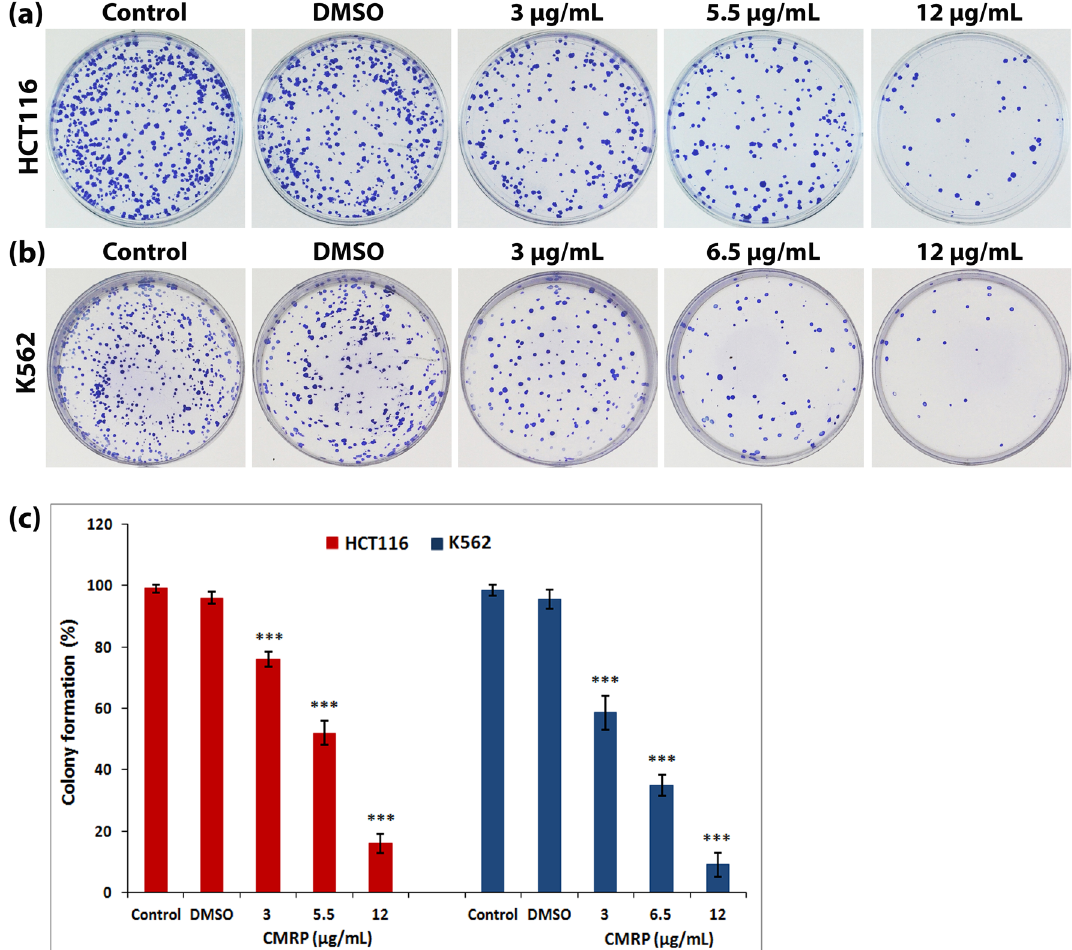
Figure 2. Clonogenic survival assay following treatment with CMRP. Clonogenic capacity of ( a ) HCT116 and ( b ) K562 cells treated with CMRP, following staining with crystal violet and ( c ) histogram showing significant percentage reduction in number of colonies compared to untreated and vehicle (DMSO)-treated controls. Values represent mean ± SD of three independent experiments; *** P <